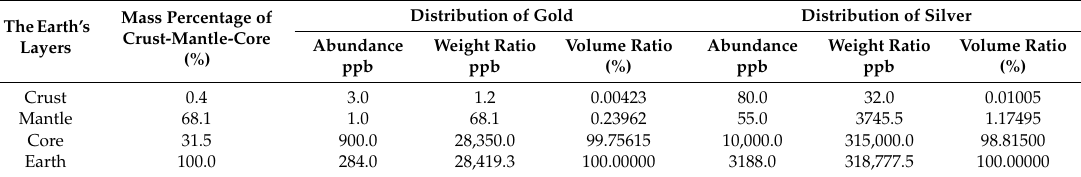
Table 3. Distribution of gold and silver in the earth’s layers